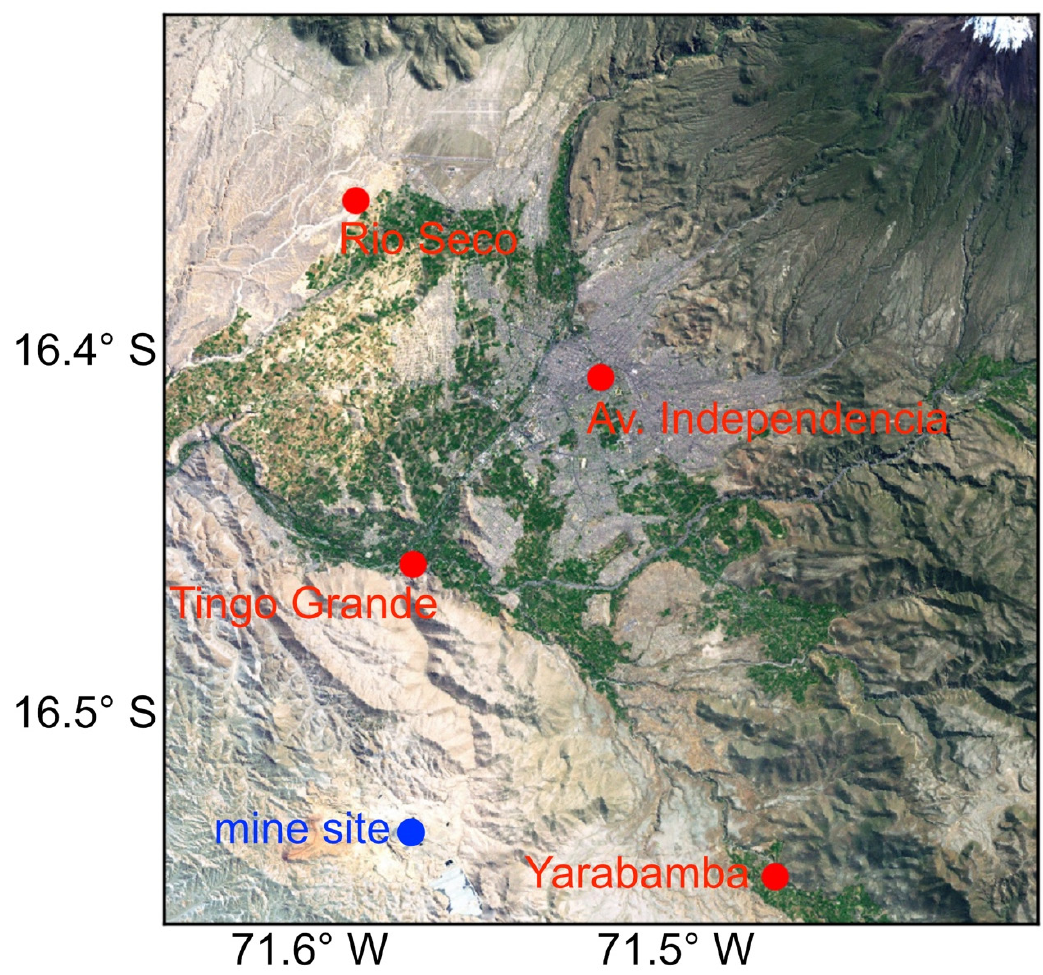
Figure 1. Map of the sampling sites. Industrial site (Rio Seco), urban site (Av. Independencia), and suburban sites (Tingo Grande and Yarabamba). Urban land cover appears grey in this image.